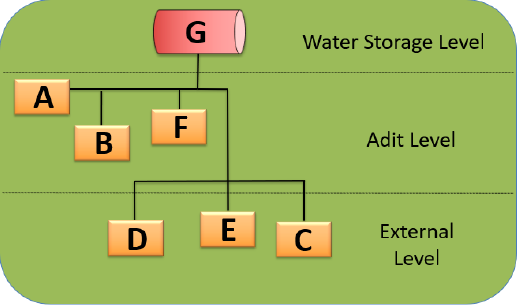
Figure 1. Diagram of water distribution system and sampling sites at the studied mine.